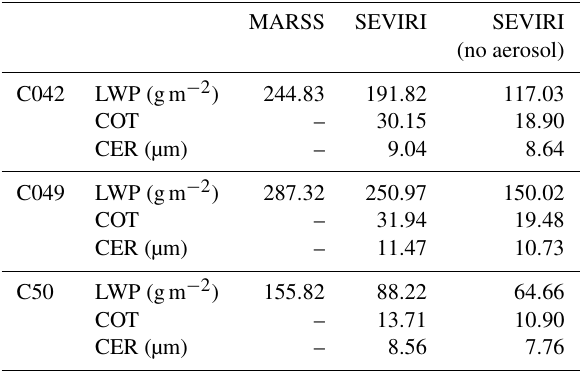
Table 3. Mean LWP observed by MARSS during the straight level run above the clouds and collocated cloud properties retrieved by SEVIRI with and without taking into account the absorption of aerosol above